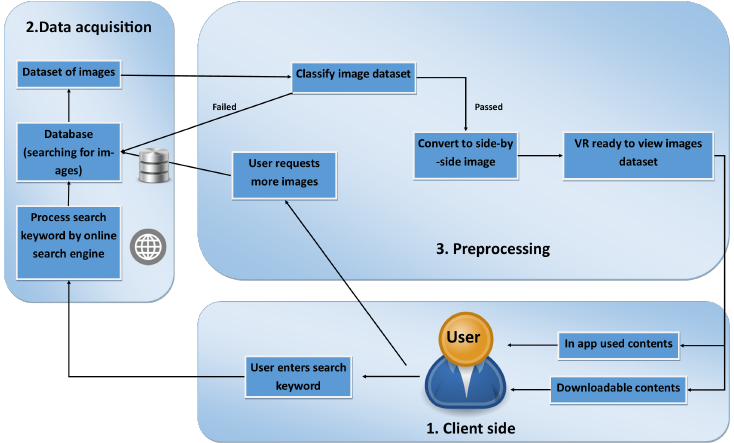
Figure 5. Architecture and Procedure of the Proposed